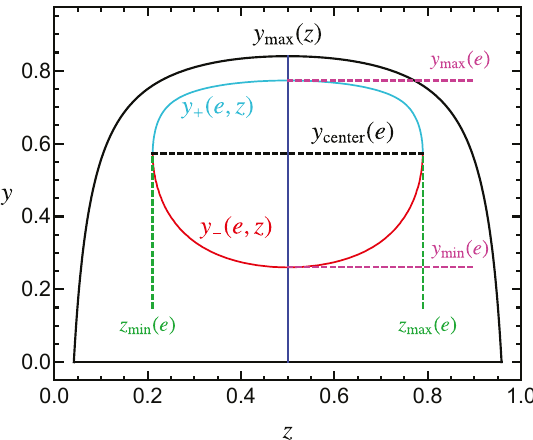
Figure 8 . Phase space diagram in ( z; y ) coordinates (black lines) showing in red and cyan the con- tour line with constant value of C-parameter, corresponding to the functions y + ( e; z ) and y (cid:0) ( e; z ), respectively. The two curves meet at the points [ z min ; max ( e ) ; y center ( e )], joined by the black, dashed line. These curves meet the z = 1 = 2 vertical blue line for y = y min ; max ( e ), respectively. Dashed magenta [green] lines mark the points of maximal and minimal values that y [ z ] can take within the red curve. To generate this plot the values ^ m = 0 : 2 and C = 0 : 42 were used.